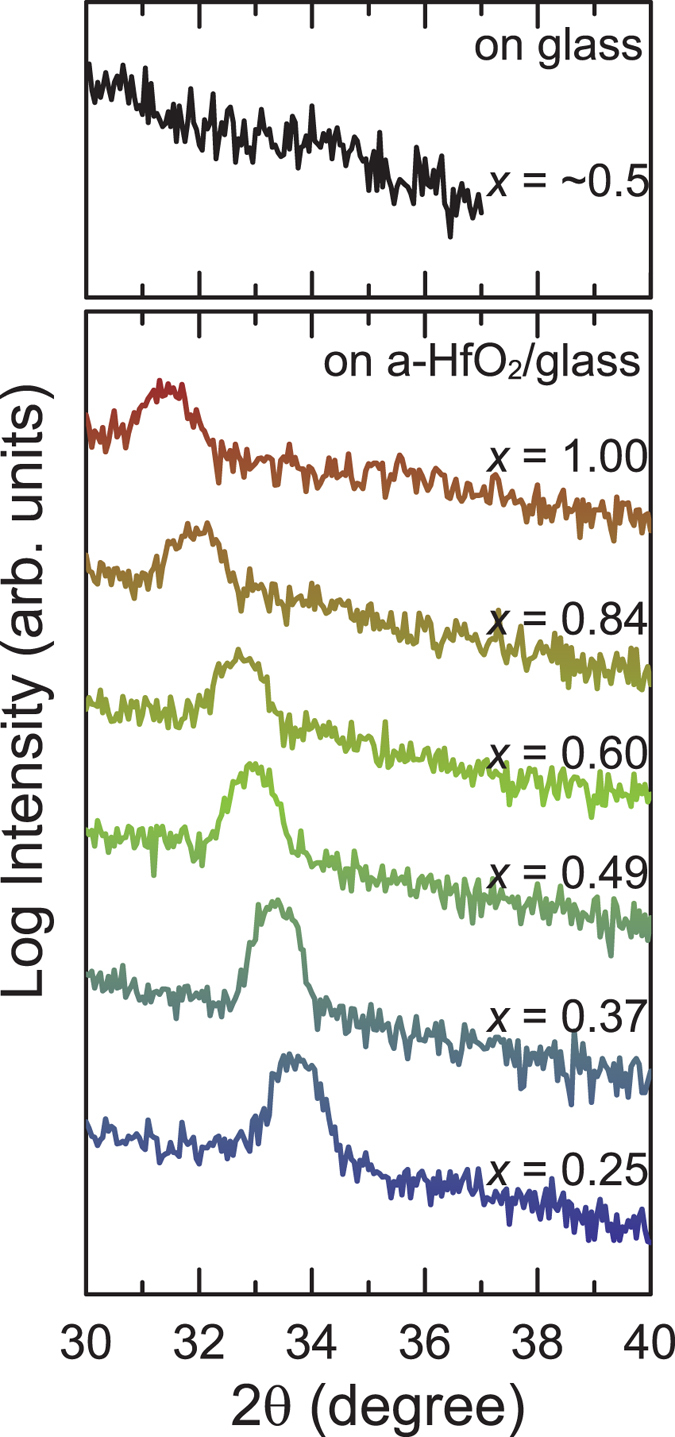
XRD 2θ scans of InxGa1−xN films with various In contents (x) grown on glass (upper) and a-HfO2-coated glass (lower).The In content indicated in the lower graph was calculated using Vegard’s law.